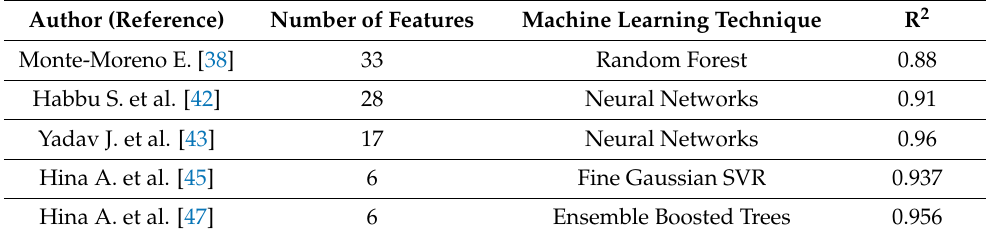
Table 3. Comparison table of the PPG-based NIR BGL